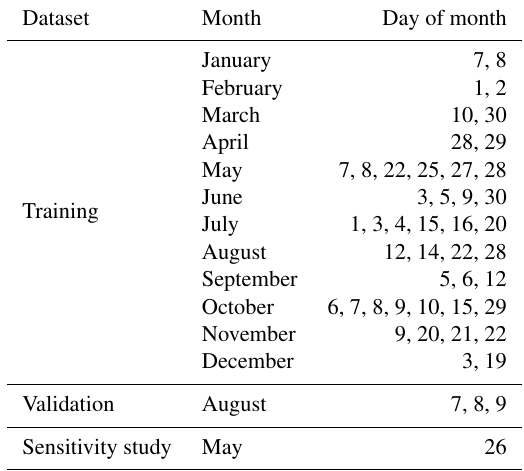
Table 1. List of the days of 2018 used in the present study. Dataset